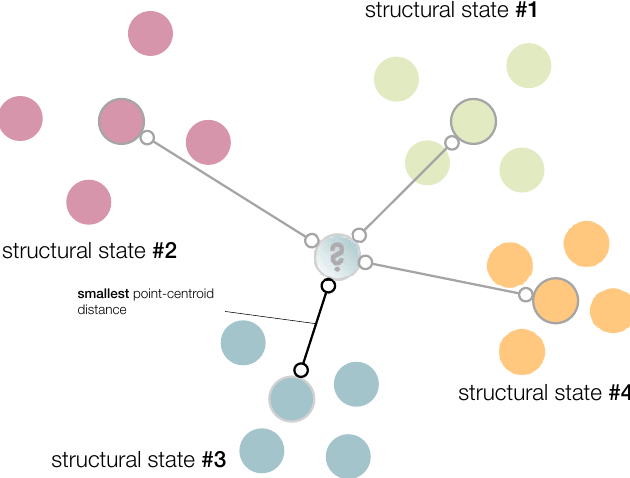
Figure 2. Current structure to diagnose is associated with the structural state with the smallest point-centroid